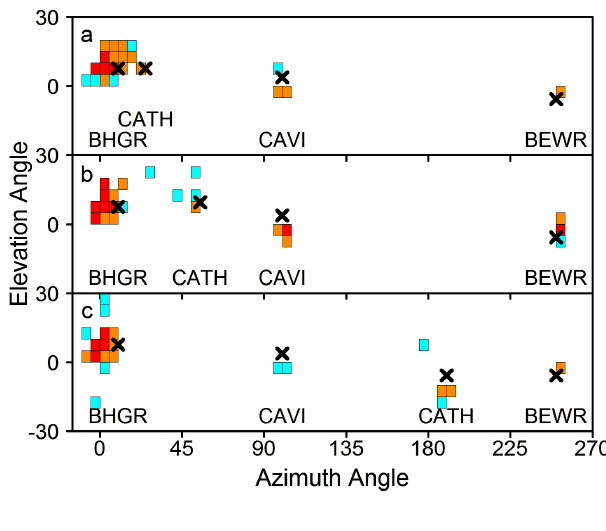
Fig. 7 . Reanalysis of the sounds recorded and analyzed in Figure 4h (a), 4i (b), and 4j (c). By focusing on nonoverlapped portions of BEWR song, the DOA of BEWR could be accurately estimated, even though every song was overlapped by the shorter and more numerous BHGR songs in the original